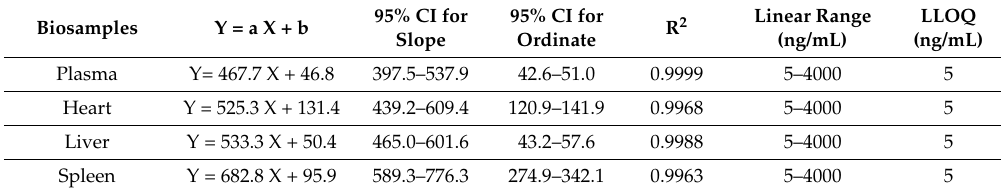
Table 1. Linearity curve of DPTM in plasma, tissue homogenates, urine and feces samples.